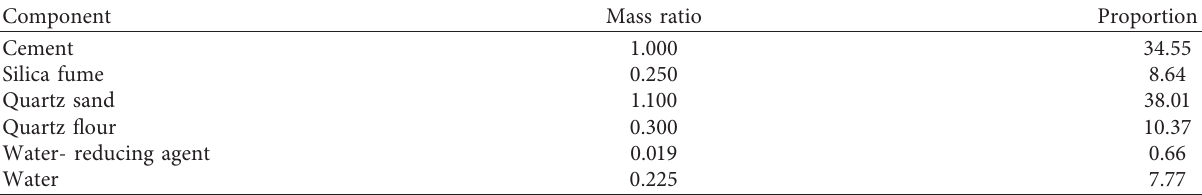
Table 2: Specific mix proportion of UHPC.